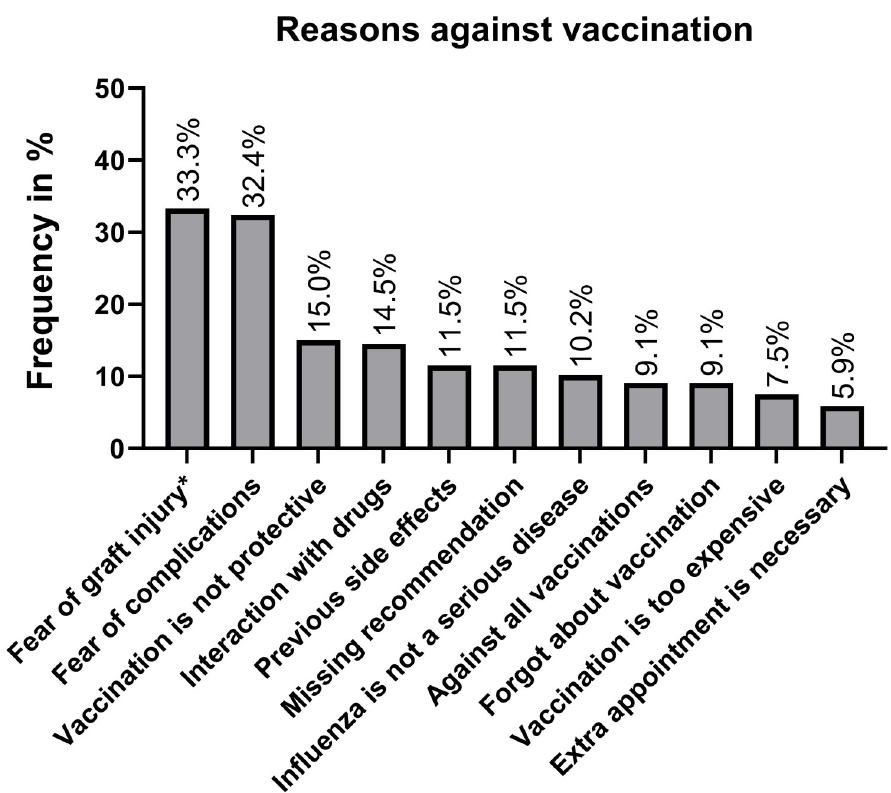
Fig 3. Most frequent arguments against influenza vaccination. Fig 3 illustrates most common arguments against influenza vaccination: � only allograft recipients included. Further, not included reasons: family advised against vaccination (N = 17/4.6%), media advised against vaccination (N = 6/1.6%), vaccination is not available (N = 16/4.3%), side effects experienced with other vaccines (N =